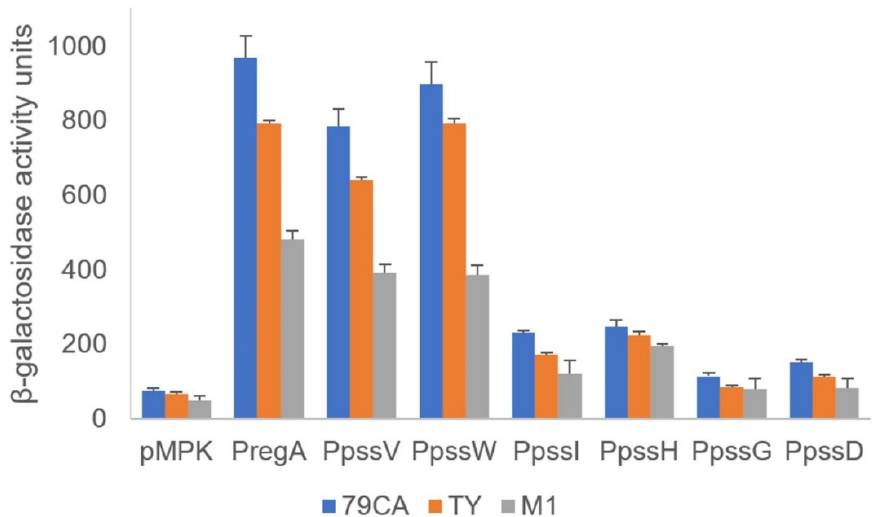
Figure 2. Transcriptional activity of hypothetical promoters in the studied fragment of the Pss-I region. PCR-amplified DNA fragments containing the predicted promoters upstream of the selected genes were cloned into the pMPK reporter vector. The β -galactosidase activities of the individual transcriptional fusions were expressed in Miller units. The presented results (with marked standard deviations) are the mean values of three independent experiments. The assays were carried out in complete (79CA and TY) and minimal (M1) media. All measured activities were significantly higher than the background ( p < 0.01), except for the activities of the pssG and pssD promoters in M1 medium, which were insignificant.